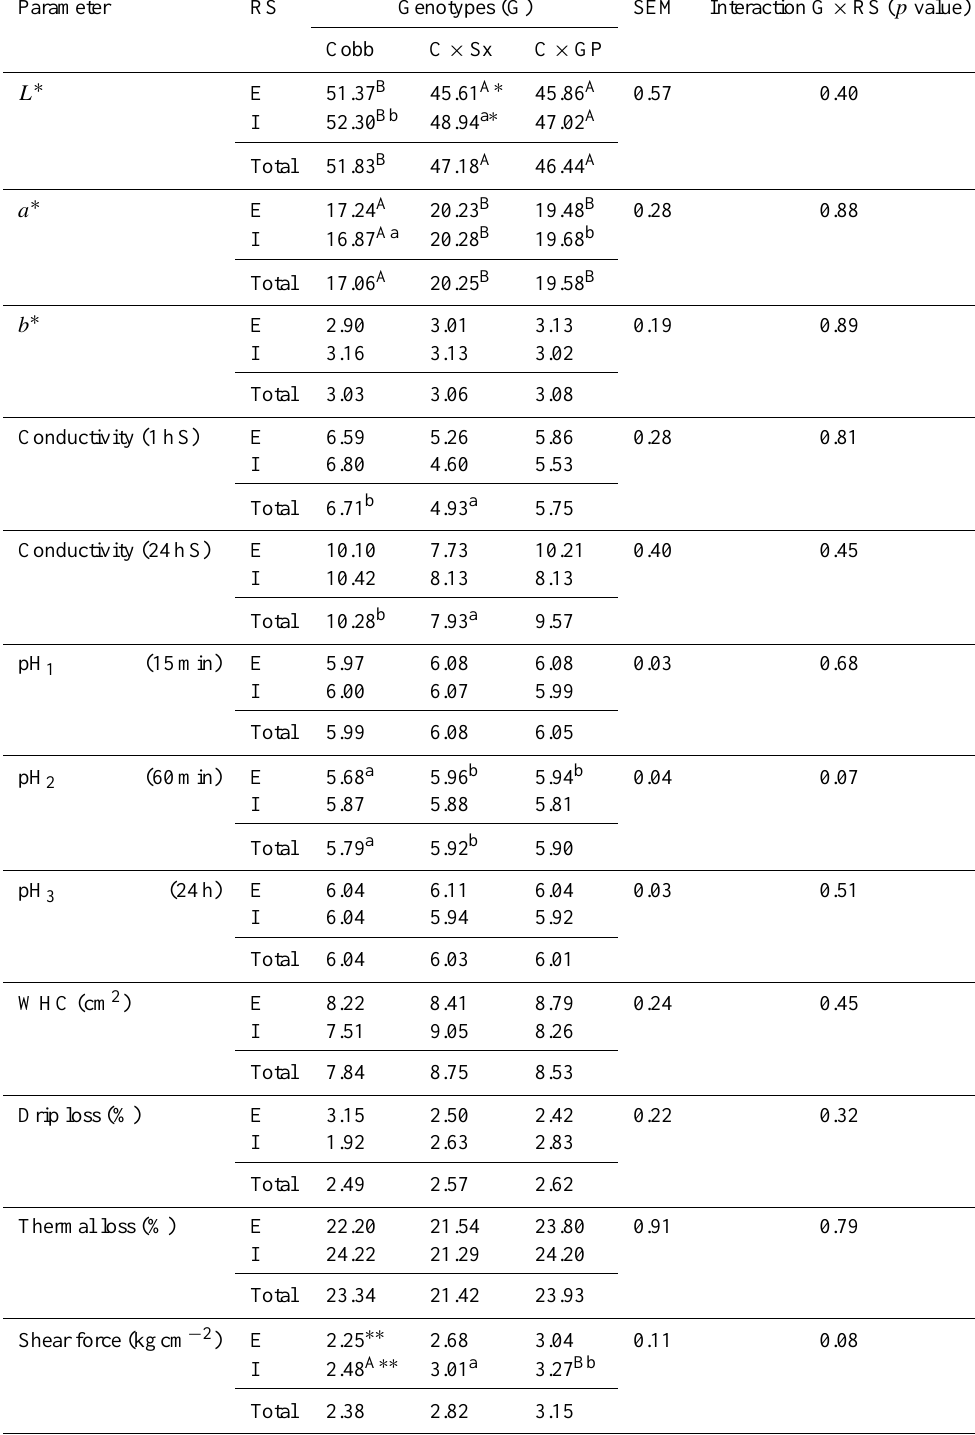
Table 7. Technological traits of meat (thigh muscle).